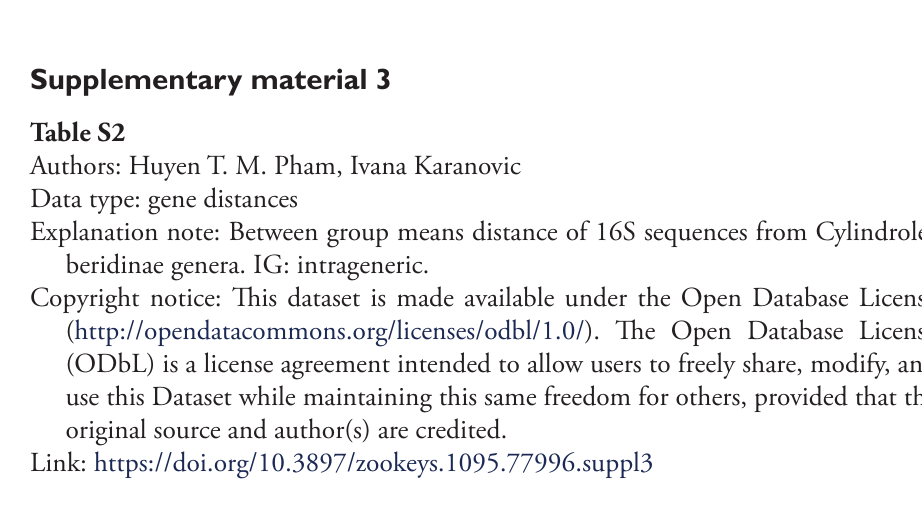
Authors: Huyen T. M. Pham, Ivana Karanovic Data type: gene